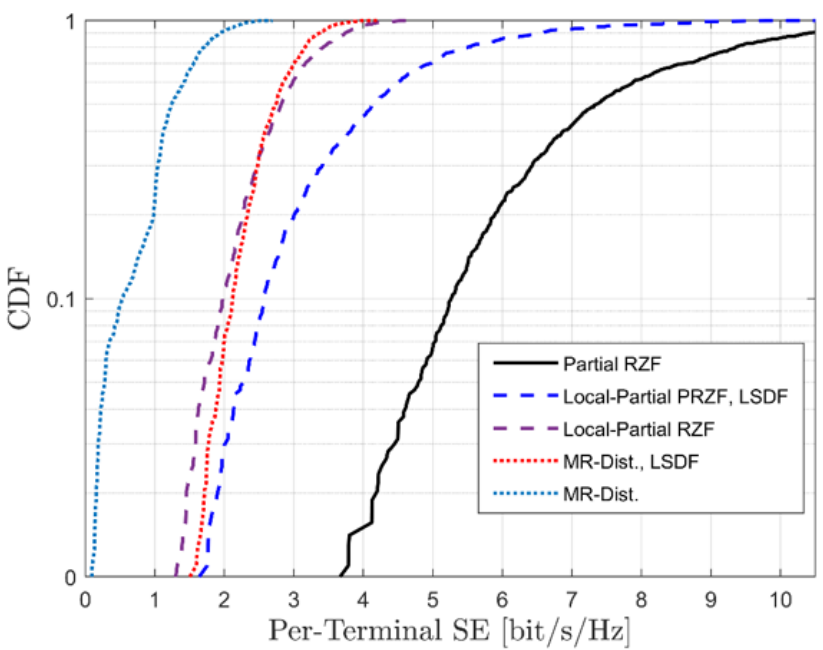
Figure 4. Cumulative Distribution Function (CDF) distribution of for an arbitrary UT as a function of the average achievable SE, with L = 256, K = 32, and τ p = 8.